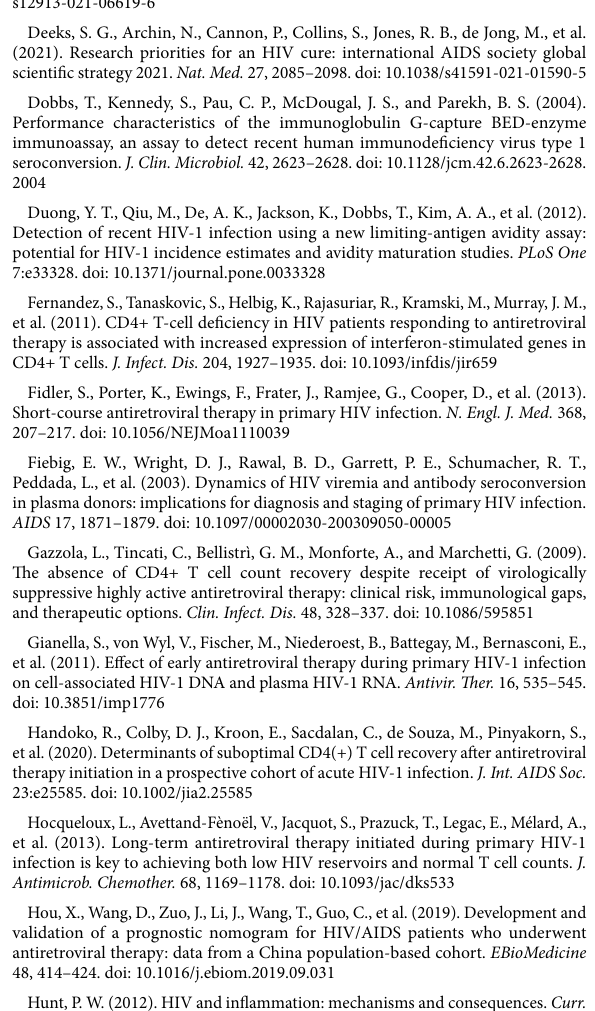
SUPPLEMENTARY FIGURE S6 The recovery speeds of CD4 + T-cell count (A) and CD4/CD8 ratio (B) in all, recent infection and long-term infection patients during consecutive time intervals after initiation of cART. *, p < 0.05; **, p < 0.01; ***, p < 0.001; ****, p < 0.0001; ns, p > 0.05: RI, recent infection; LI, long-term infection; mo,